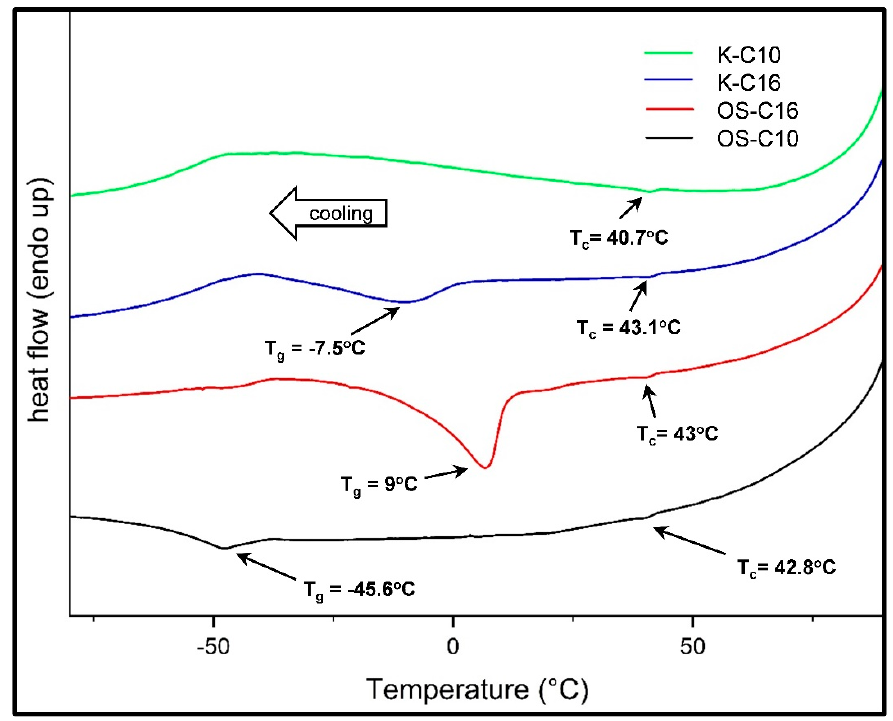
Figure 7. DSC analysis of functionalized lignins indicating glass transition (Tg) and crystallization (Tc) temperatures.